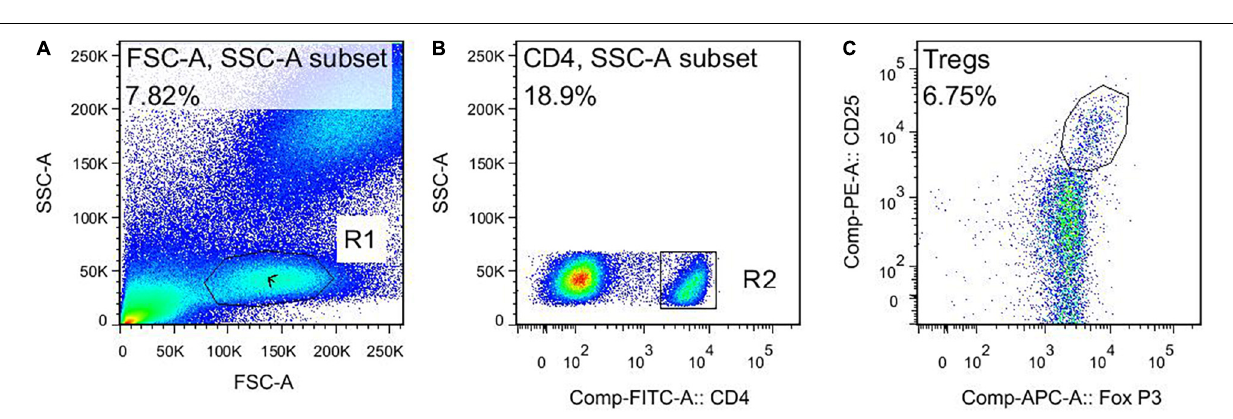
FIGURE 3 | The flow cytometry gating strategy for Treg. (A) Lymphocytes. (B) The CD4 + cells. (C) The Treg cells (CD4 + CD25 + Foxp3 +